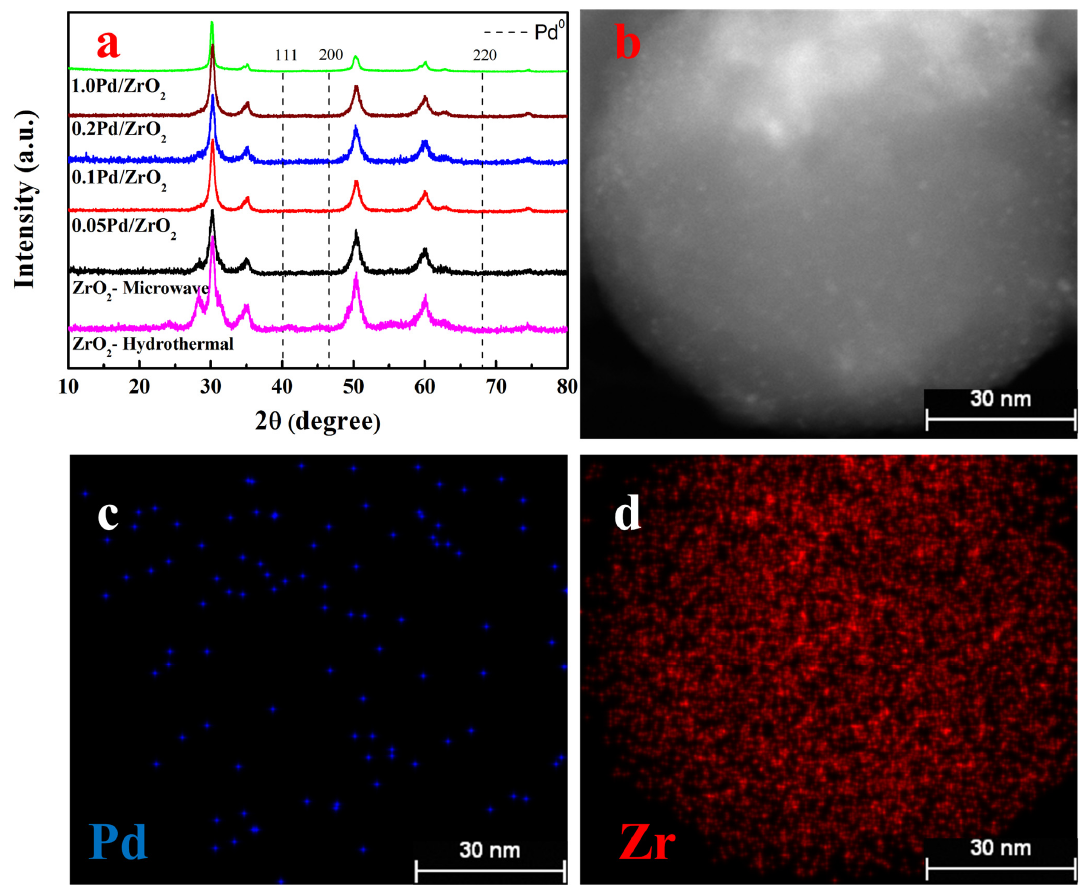
Figure 2. X ‐ ray diffraction patterns of Pd/ZrO 2 ( a ); AC ‐ HAADF ‐ STEM image of 0.2 Pd/ZrO 2 catalyst Figure 2. X-ray diffraction patterns of Pd/ZrO 2 ( a ); AC-HAADF-STEM image of 0.2 Pd/ZrO 2 catalyst ( b ); energy ‐ dispersive X ‐ ray element mapping images for Pd ( c ) and Zr ( d ). ( b ); energy-dispersive X-ray element mapping images for Pd ( c ) and Zr ( d ). Microwaves are electromagnetic waves containing electric and magnetic field components. Microwaves are electromagnetic waves containing electric and magnetic field